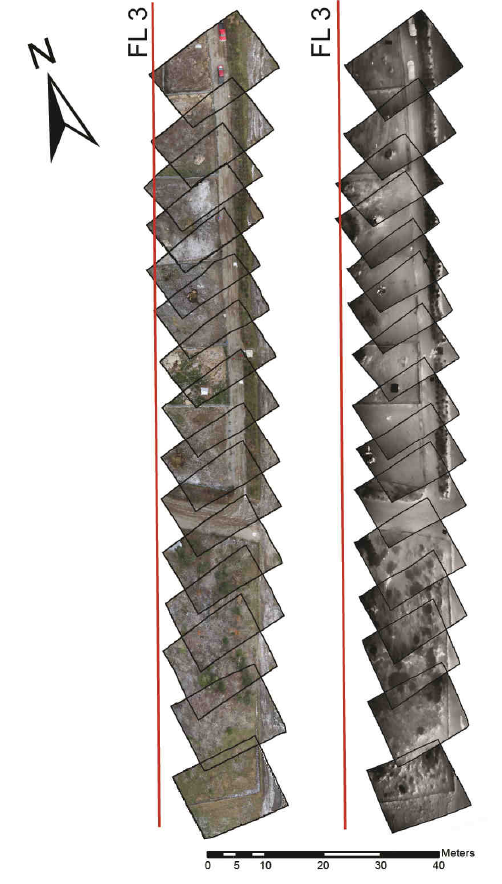
Figure 7. Georeferenced images from flight line n°3 (FL 3). Left: visible imagery. Right: thermal infrared